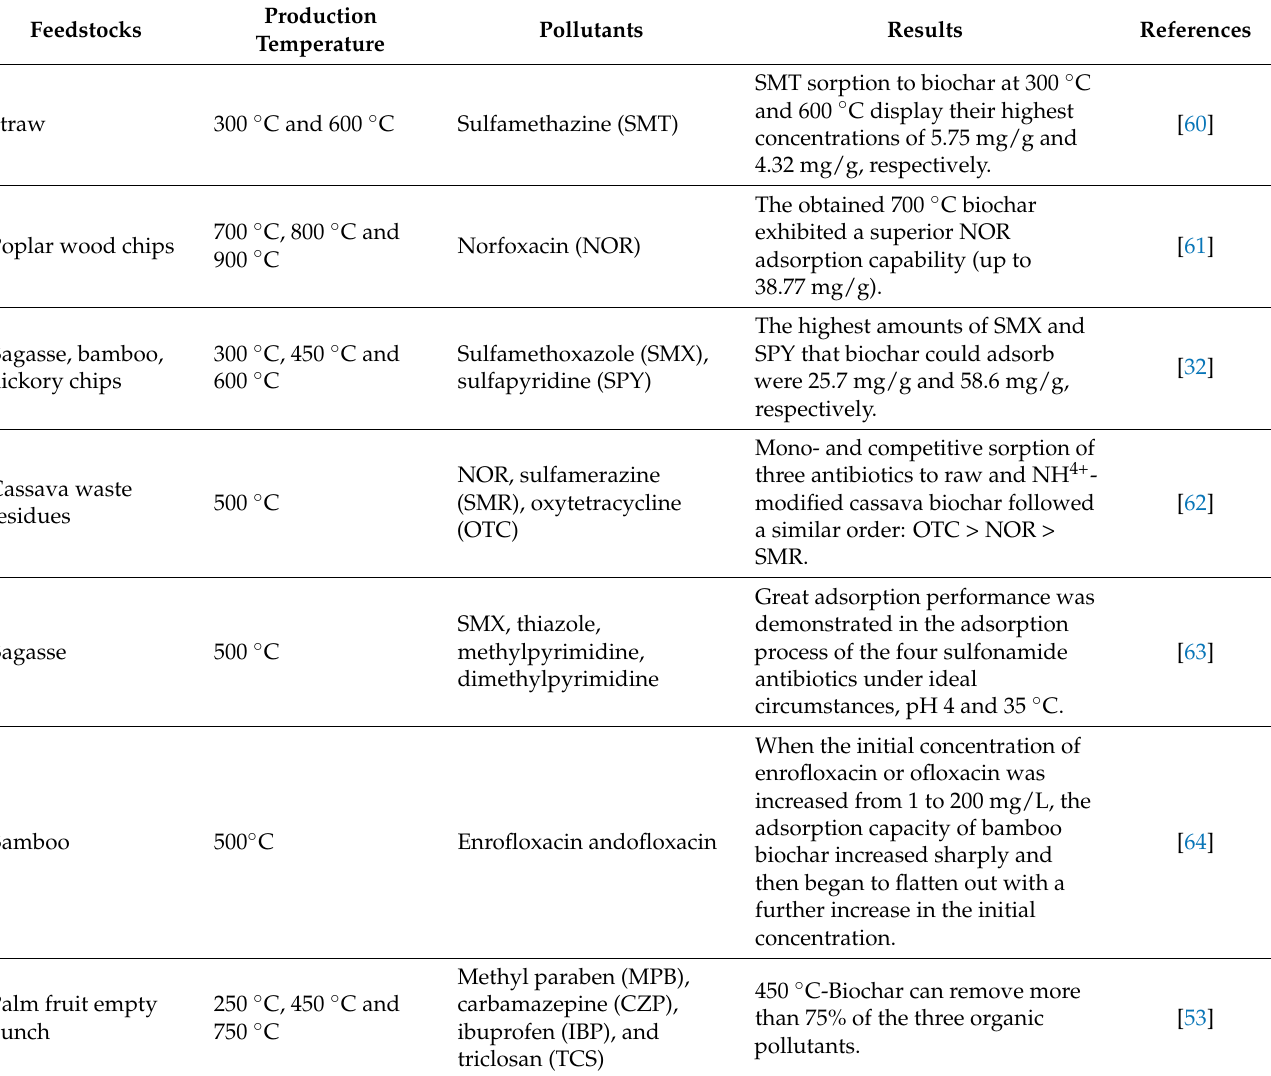
Table 3. Representative studies on the removal of PPCPs from aquatic systems by